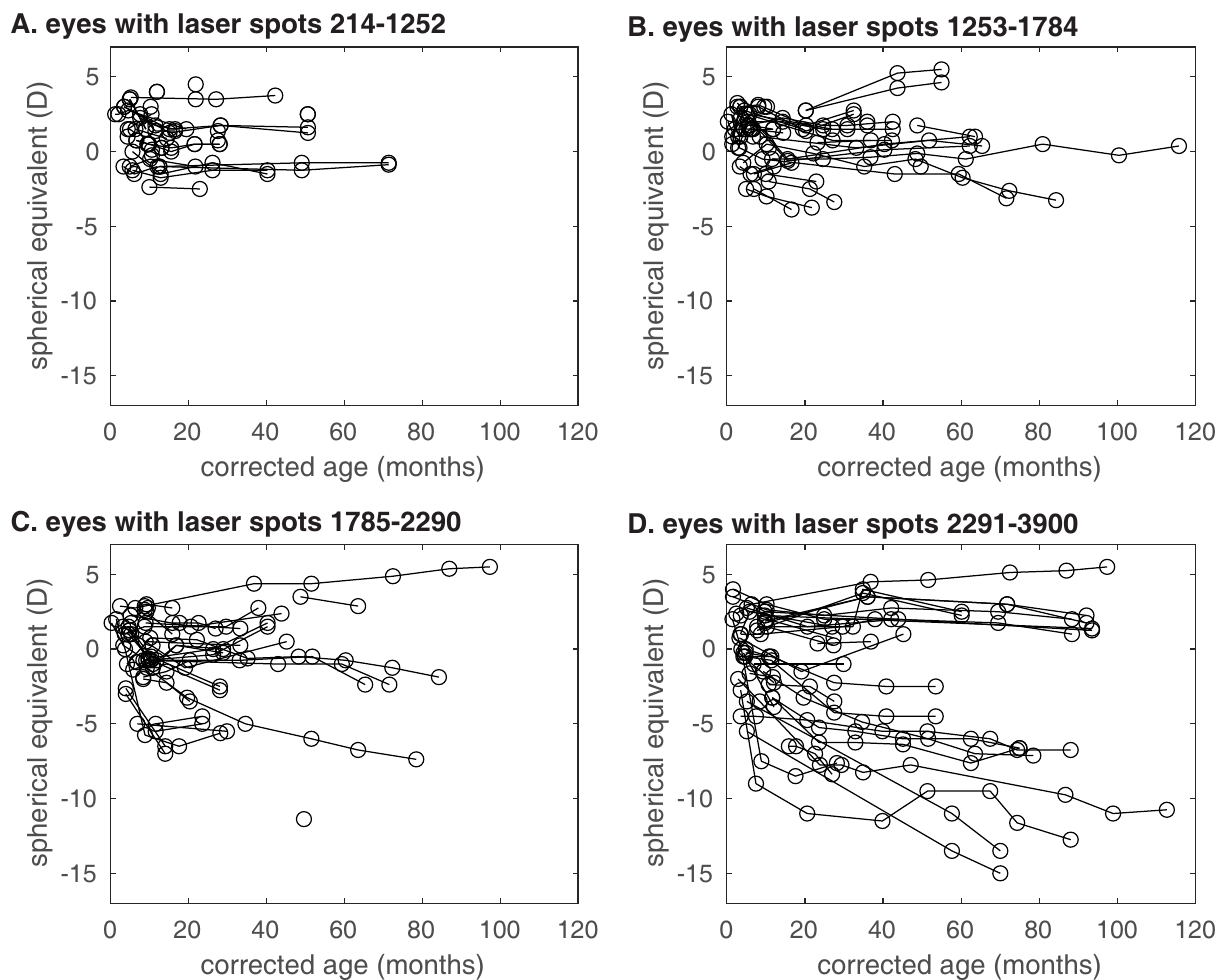
Fig 1. Changes in refractive error with age. One line represents one eye. Eyes were plotted in subgroups based on the number of laser spots received during treatment for retinopathy of prematurity. (A) first quartile of laser spots; (B) second quartile; (C) third quartile; (D) fourth quartile. https://doi.org/10.1371/journal.pone.0279898.g001 and time was -0.30 D (95% confidence interval -0.53 to -0.08), signifying that an increase in the number of laser spots by 1,000 is associated with additional myopia of 0.30 D per year. The coefficient in the bivariate model was similar (-0.31), indicating that other covariates are not confounding the association between spherical equivalent and the interaction of laser spots and time. Many eyes in the highest quartile in terms of number of laser spots (Fig 1D) did not develop myopia, indicating that there are other factors affecting myopia development after laser for ROP.